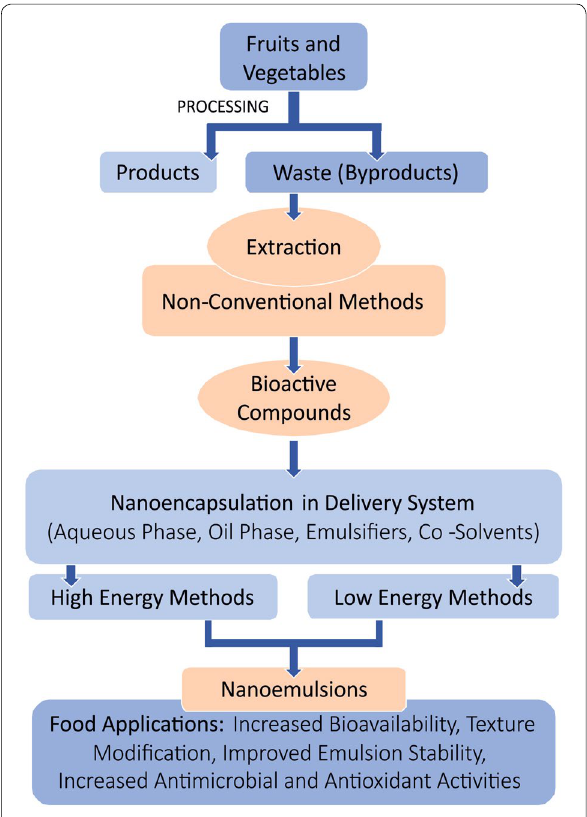
Fig. 1 Schematic representation of extraction